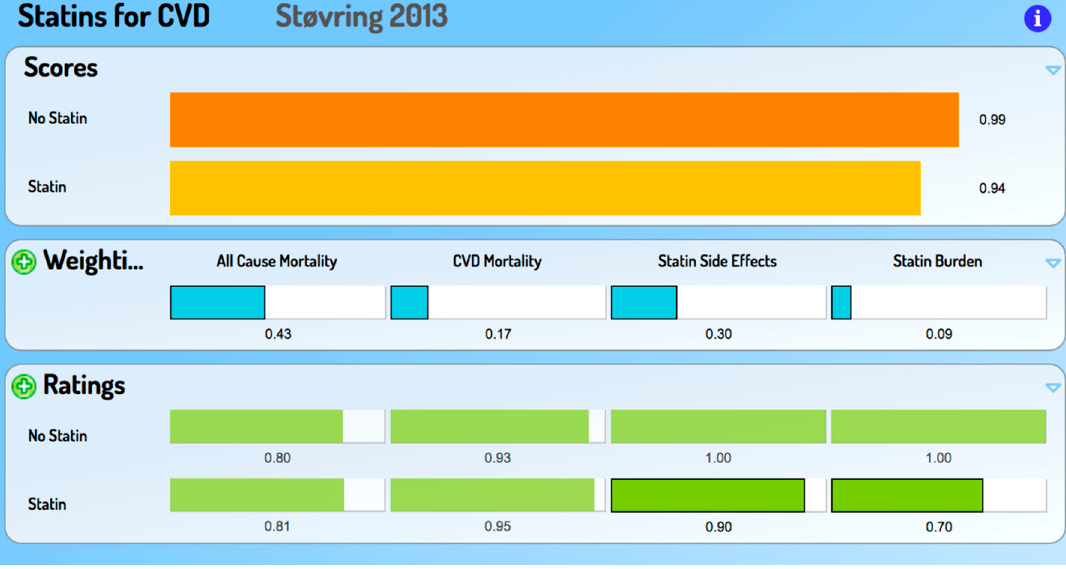
Figure 2. Final screen capture for Statin decision, reflecting pre ‐ entered and supplied Ratings and Weightings.